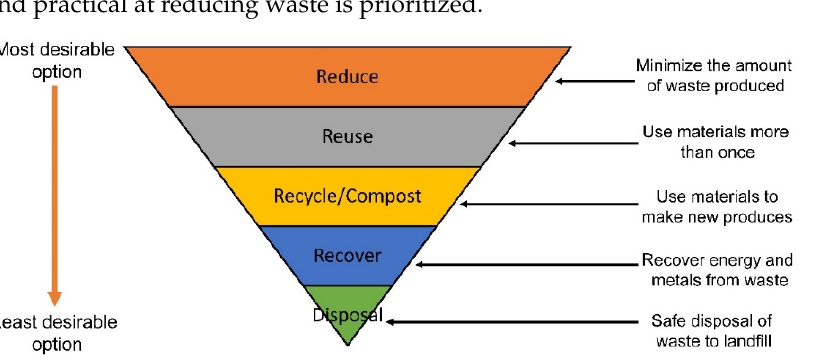
Figure 4. The global waste management hierarchy [29].